Question: Provide a one-line summary of what is displayed.
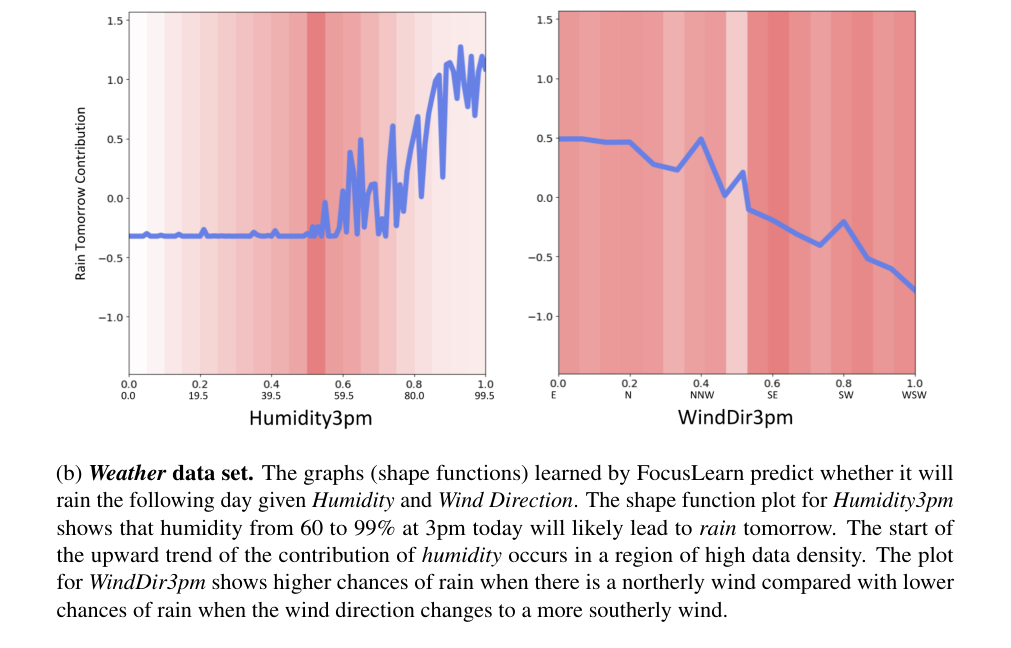
Answer: NAM-style explanations for selected features learned by MNN. Network outputs are shown on the y-axis. Feature values are shown on the x-axis (normalised values above and actual values below). The blue line represents the learned shape function. Normalised data densities are shown using the red bars, the darker the red, the more data is available in that region.